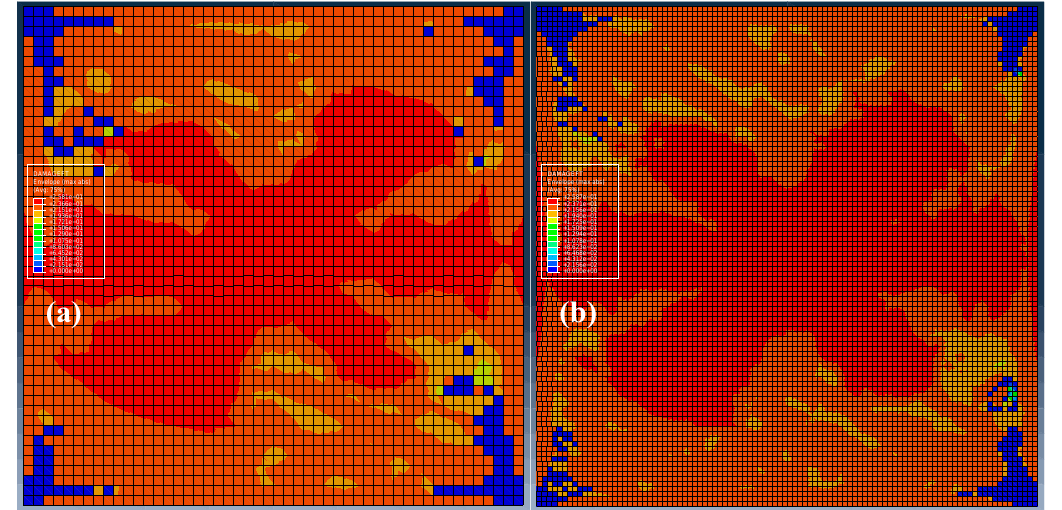
Figure 10. The comparison of fiber-tension damages in the laminate (material 1) with different meshes: ( a ) relatively coarse mesh, ( b ) dense mesh.